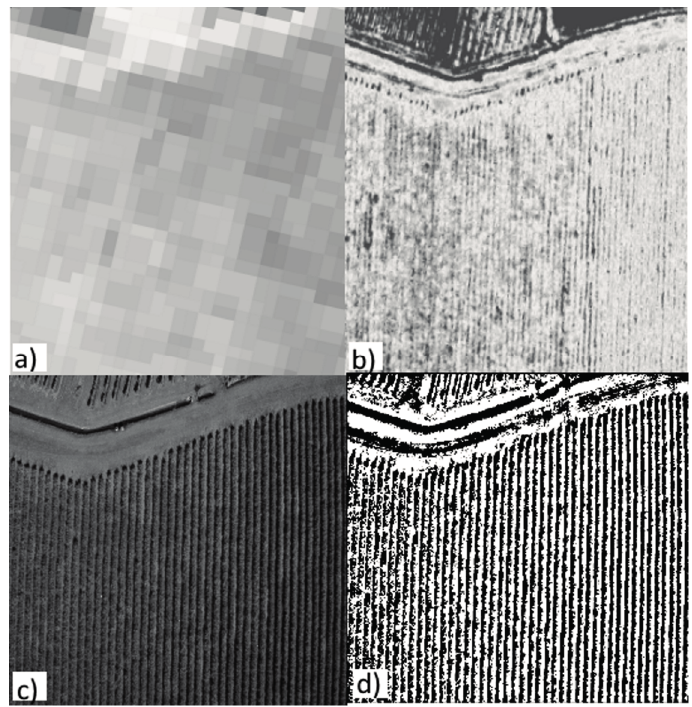
Figure 6. ( a ) Vineyard portion of Satellite image; ( b ) Vineyard portion of Aircraft image; ( c ) Vineyard portion of UAV image; and ( d ) Vineyard portion of UAV image with inter-row